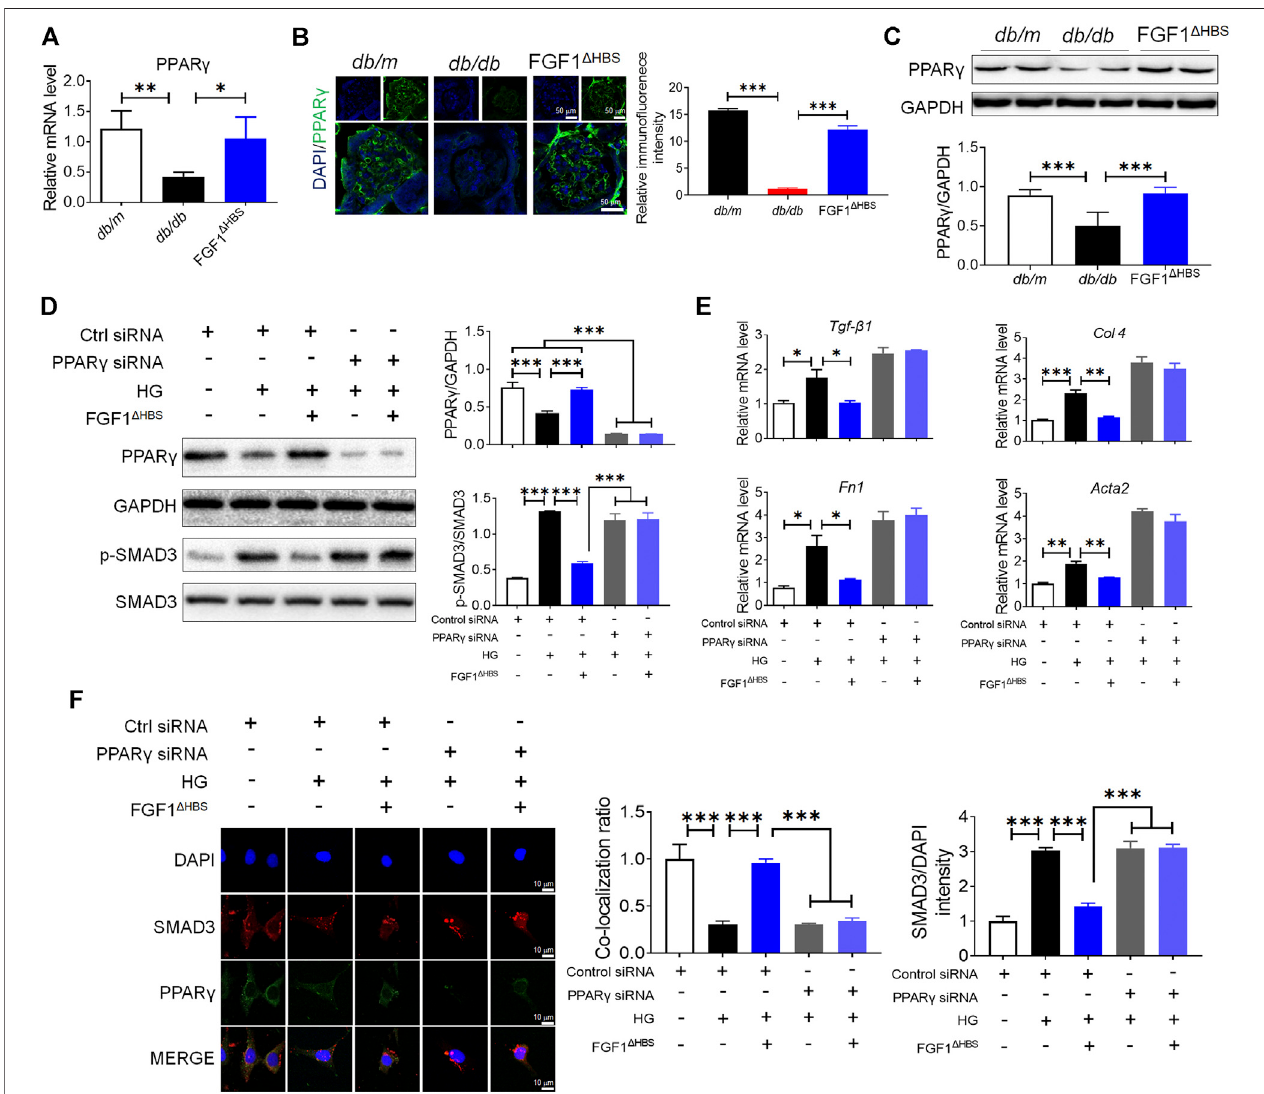
FIGURE3| PPAR γ mediatedtheprotectiveeffectsofFGF1 Δ HBS onpodocyteEMTindiabeticconditions. (A) Real-timePCRanalysisofPPAR γ mRNAexpression. (B) Representative images and quantitation of immuno fl uorescence staining for PPAR γ . (C) Expression levels of PPAR γ as determined by western blot analysis and quantitation using ImageJ. (D) Phosphorylation levels of SMAD3 and protein expression of PPAR γ as determined by western blot analysis and quantitation using ImageJ. (E) Real-time PCR analysis of TGF- β 1 , Fn1 , Col 4 , and Acta2 mRNA expression. ( F ) Representative images and quantitation of immuno fl uorescence staining of SMAD3 and PPAR γ . In panels (A – C) , data are presented as the mean ± SEM ( n (cid:1) 6). In panels (D – F) , data from three independent measurements are presented as the mean ± SEM; * p < 0.05, ** p < 0.01, *** p < 0.001.